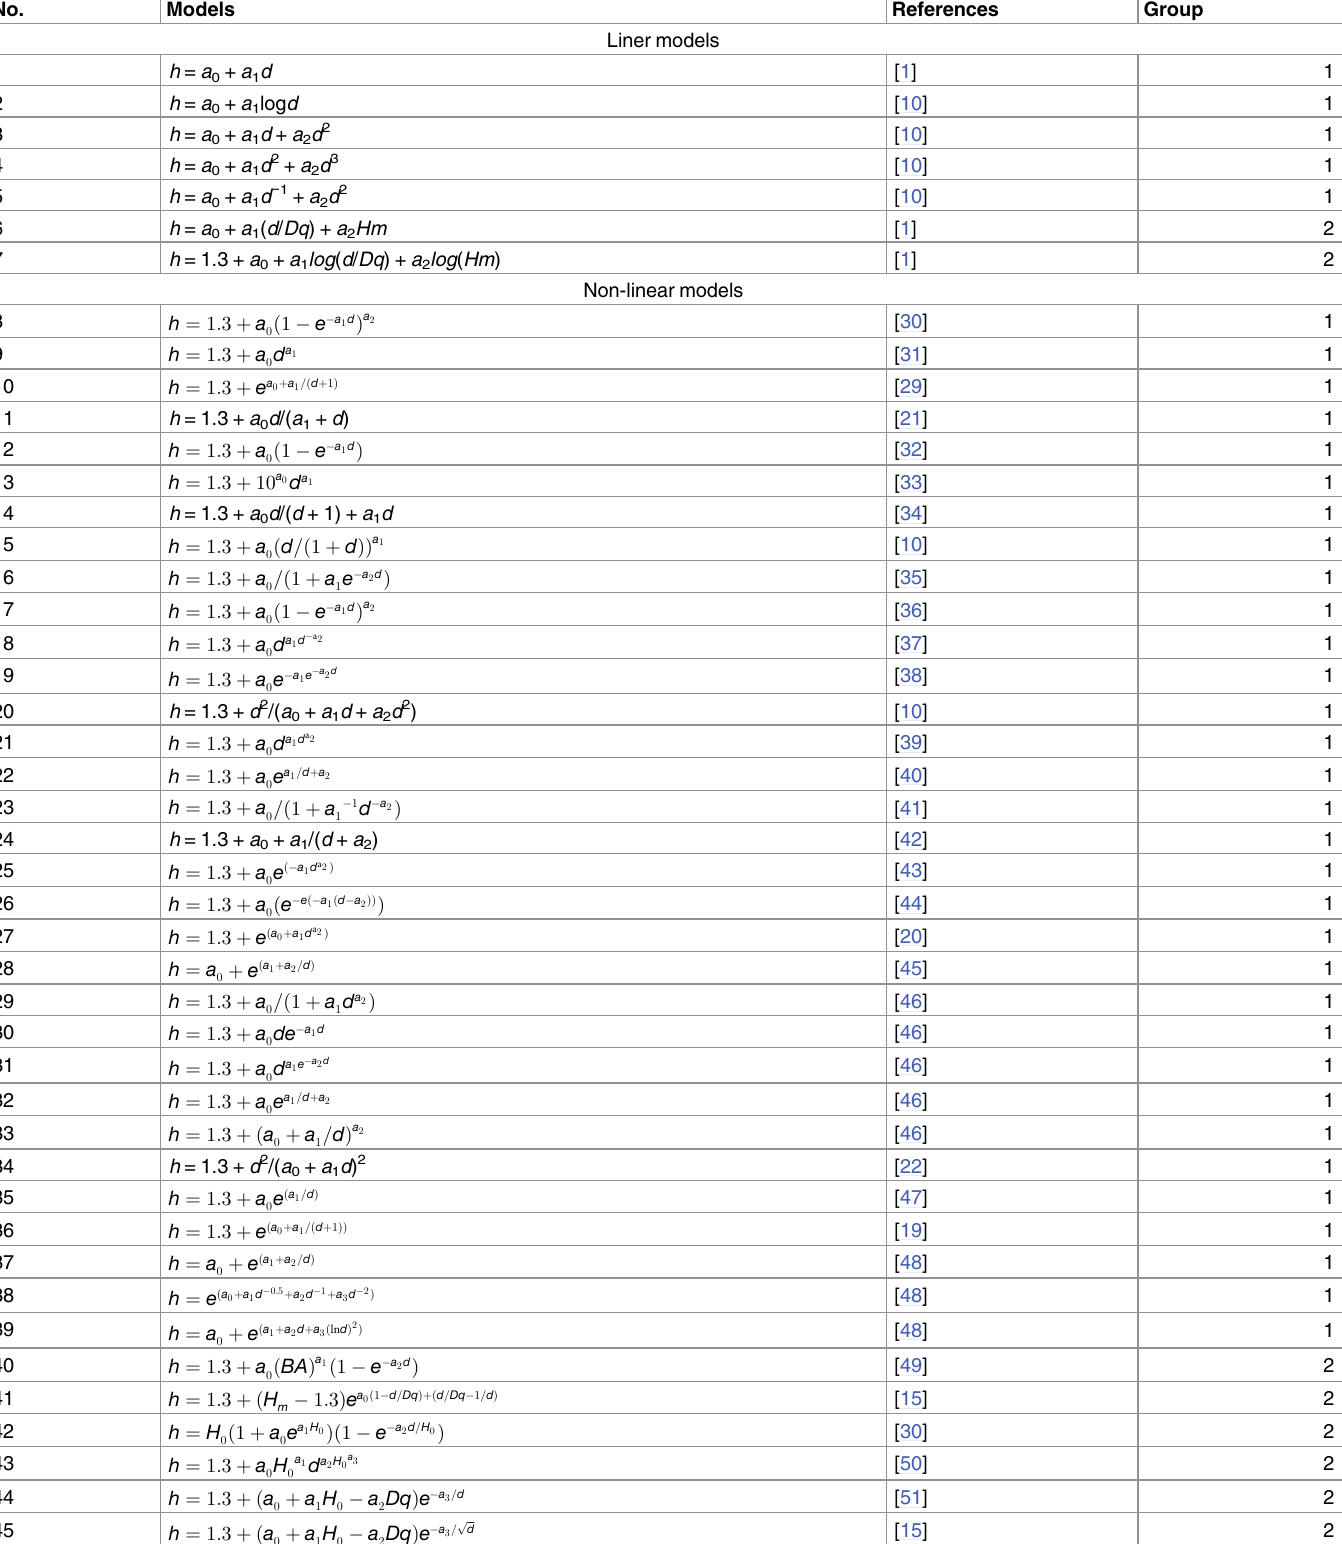
Table 2. Selected tree height-dbh